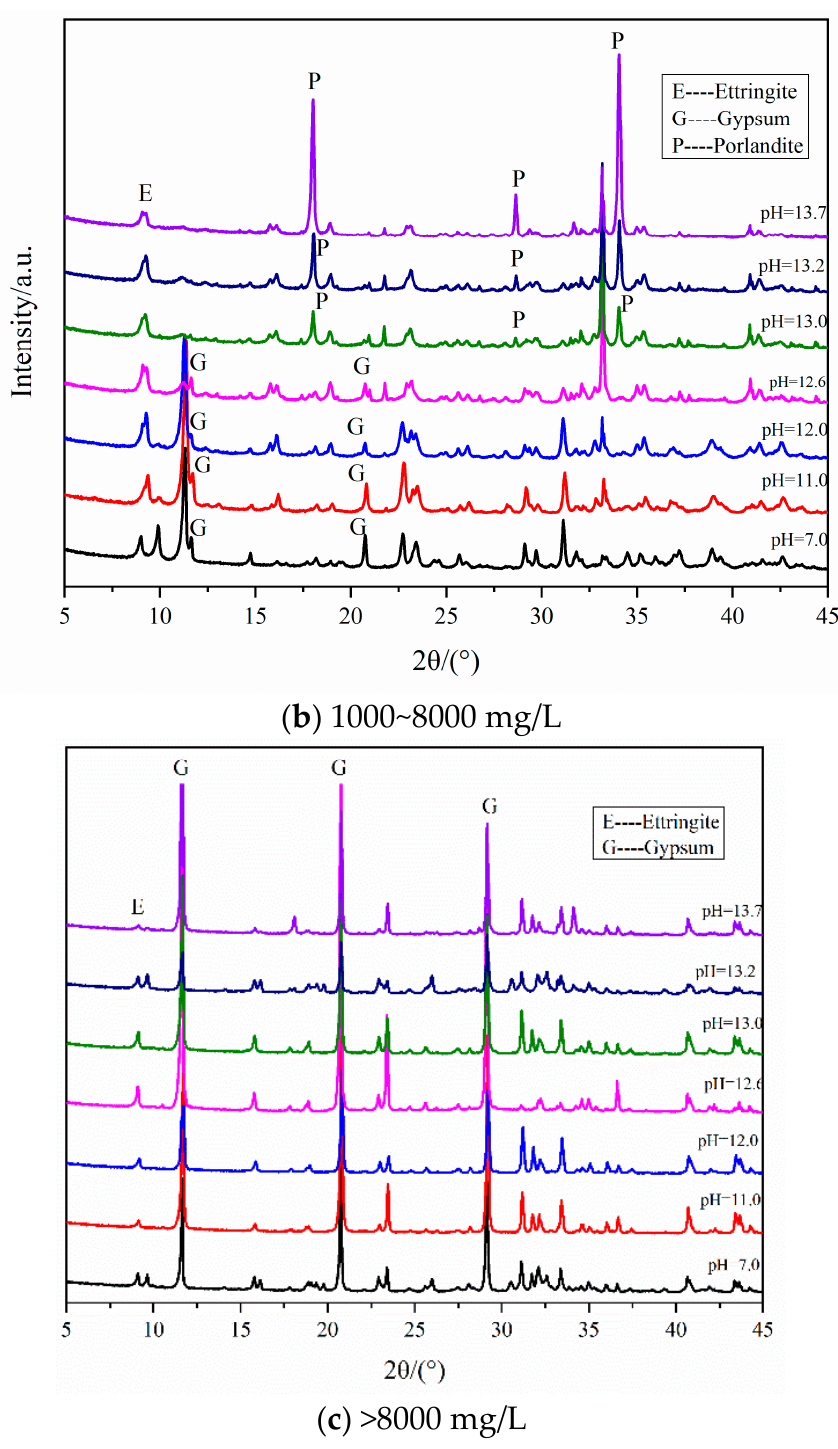
Figure 18. Patterns of products at different pH values.